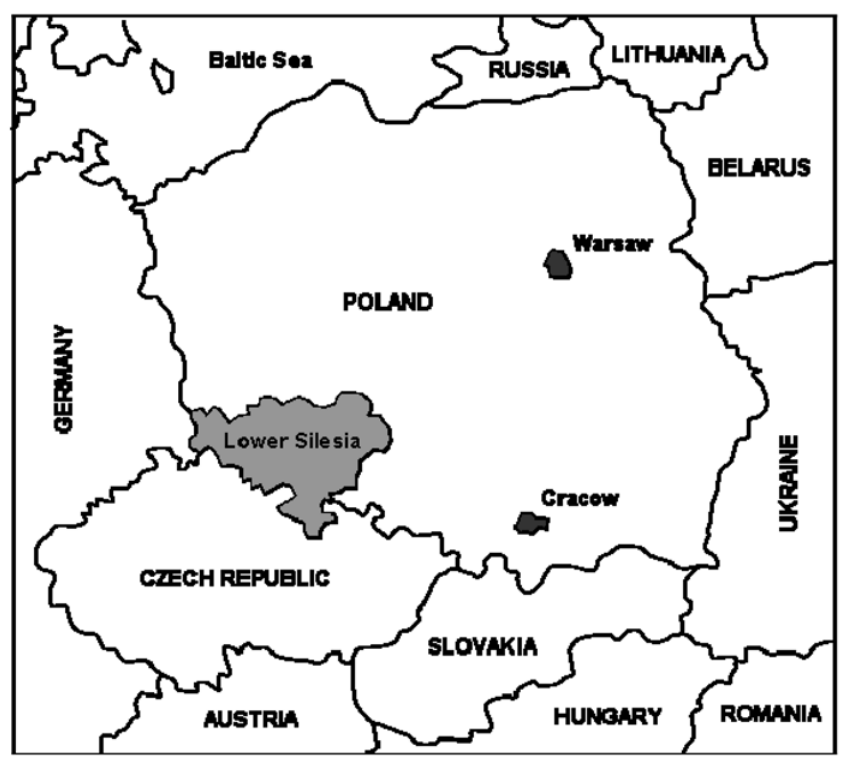
Fig. 1 Schematic presentation of the Lower Silesian province in Central